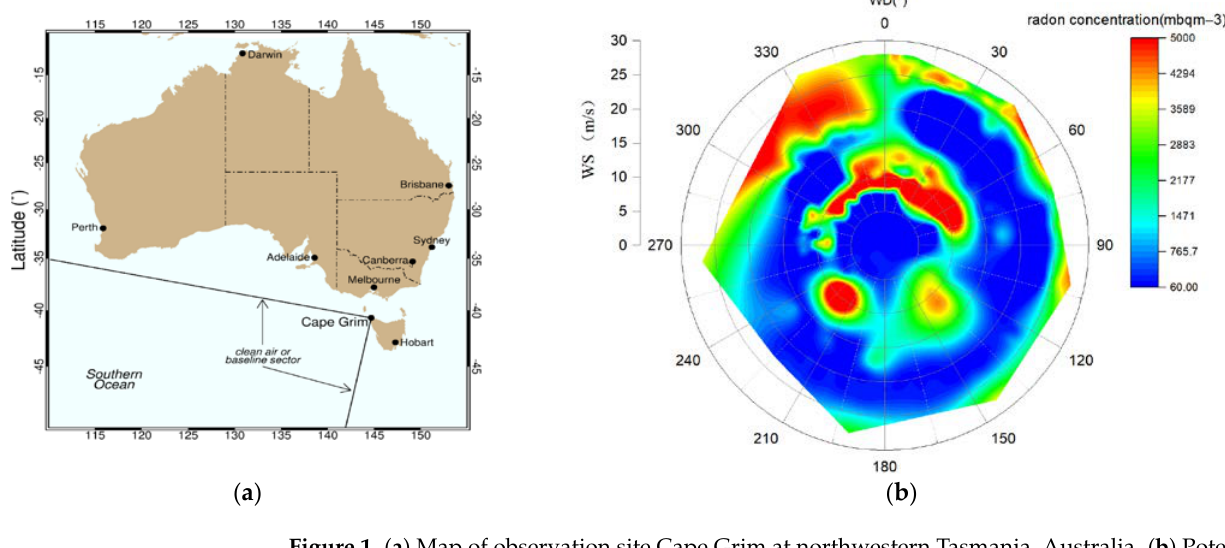
Figure 1. ( a ) Map of observation site Cape Grim at northwestern Tasmania, Australia. ( b ) Potential sources of radon in the observing period.